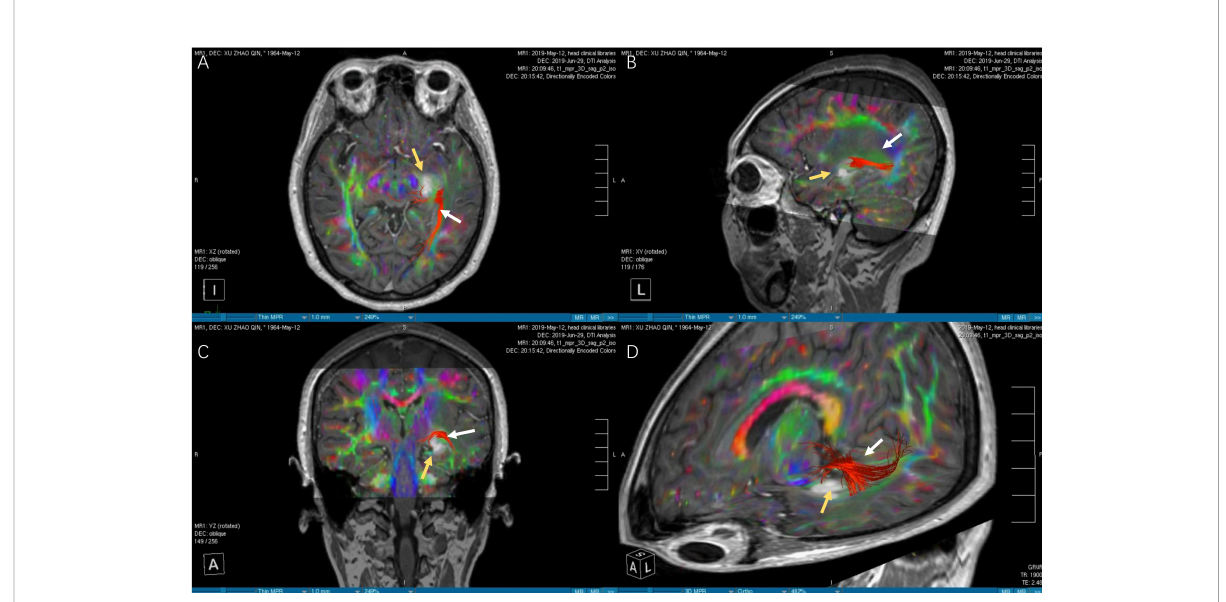
FIGURE 3 The images of DTI tractography of patient No.12 (OpR morphology score = 3). The DTI data was imported into the StealthViz ® software for neuronavigation. The lateral geniculate body and the rectangular sulcus were set as regions of interest to reconstruct the OpR on the affected side. (A) The axial image showed partial disruption of left OpR. (B) In sagittal view, the OpR on the affected side can be seen behind and above the tumor. (C) The coronal image showed that the tumor pushed the starting position of the OpR upward. (D) The OpR was partially interrupted (OpR morphology score=3) and was located above and behind the tumor, based on 3D reconstruction. Therefore, the inferior temporal gyrus approach was applied to avoid OpR. The white arrow indicates the OpR and the yellow arrow indicates the tumor. DTI, diffusion tensor imaging, OpR, optic